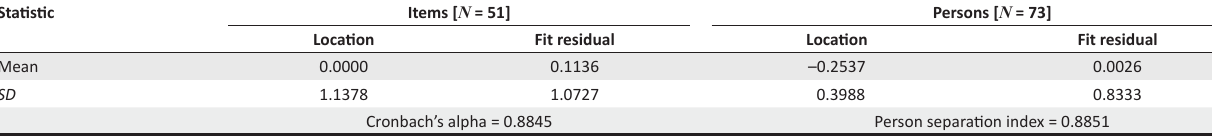
TABLE 1: Summary statistics prior to rescoring.